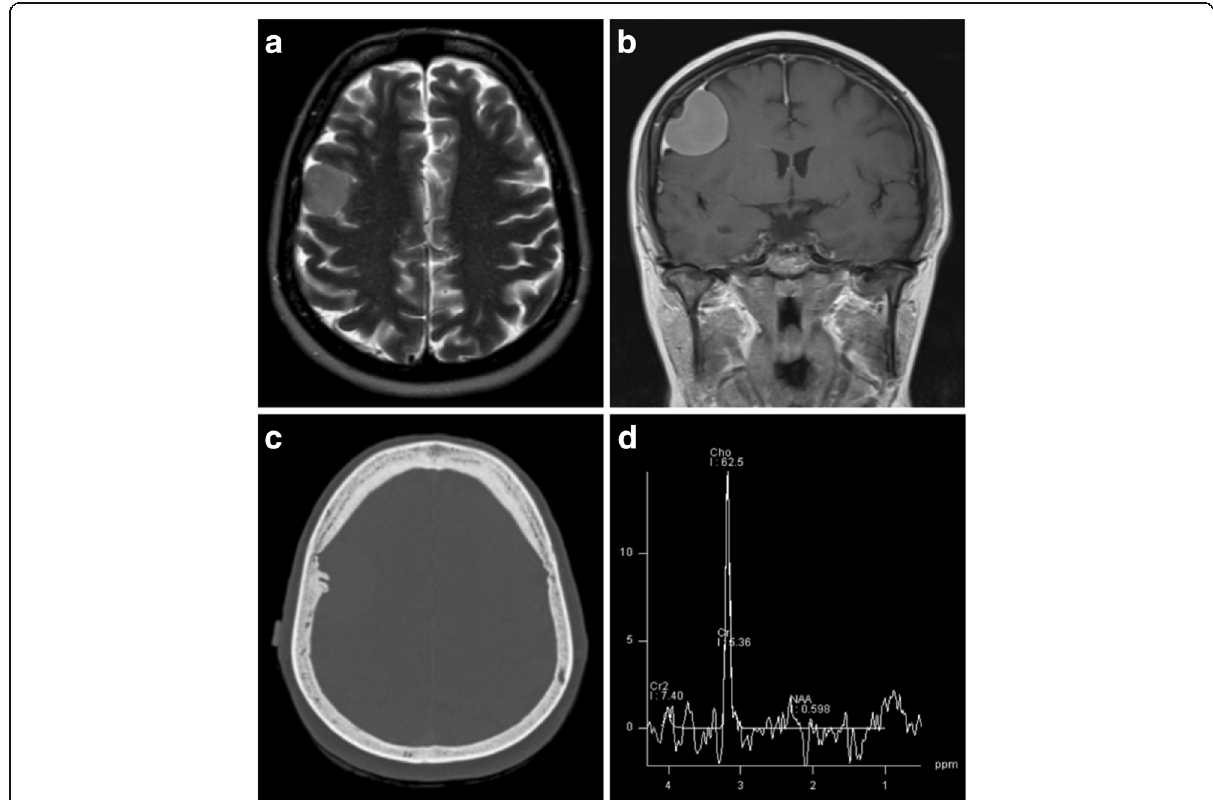
Fig. 1 Typical meningioma. a Axial T2-weighted MR image of a well-circumscribed meningioma indenting the cortex with a small cleft of CSF. b Coronal post-contrast T1-weighted image showing uniform enhancement, an enhancing-thickened dural tail and hyperostosis of the overlying calvarium. c Unenhanced CT illustrating the adjacent hyperostosis of the skull. d Magnetic resonance spectroscopy of a similar meningioma demonstrating a high choline:creatine (Cho:Cr) ratio and a low N-acetylaspartate (NAA)